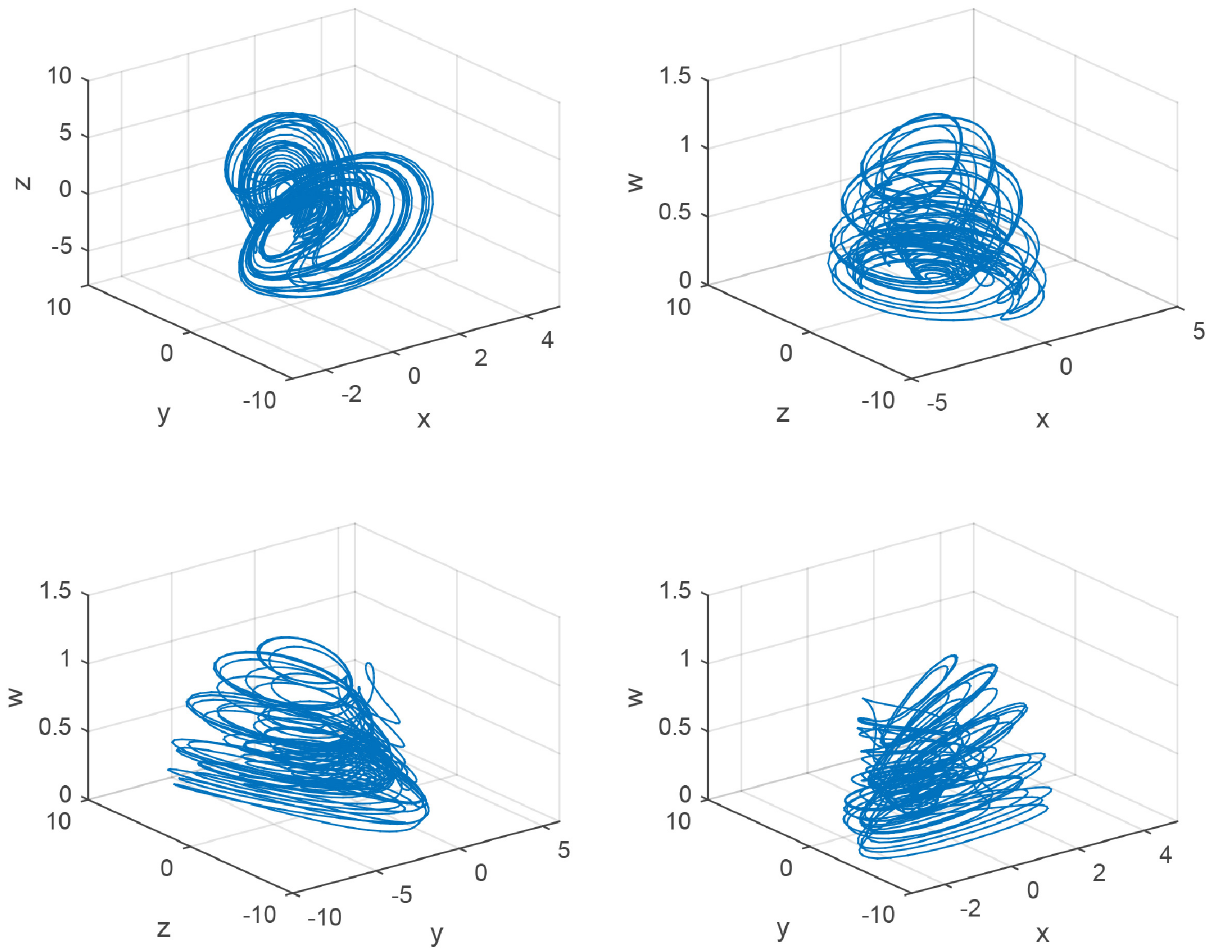
Fig 4. The 3D view of the GDDS chaotic attractor with c 2 =